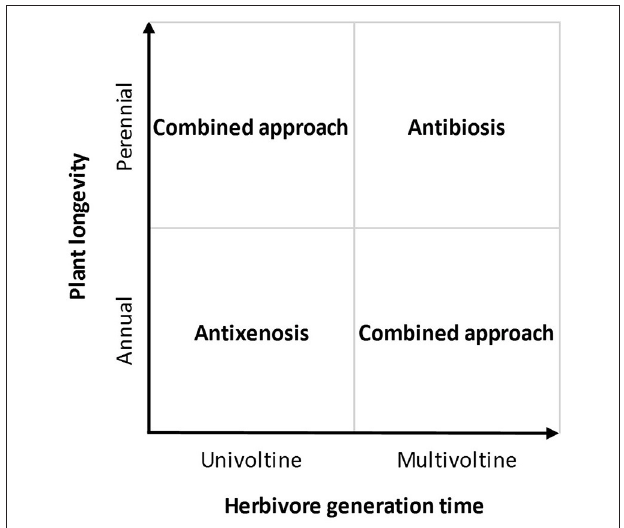
FIGURE 1 | Schematic showing which approach for measuring plant resistance would be most appropriate depending on the longevity of the crop plant (or culture) and the generation time of the